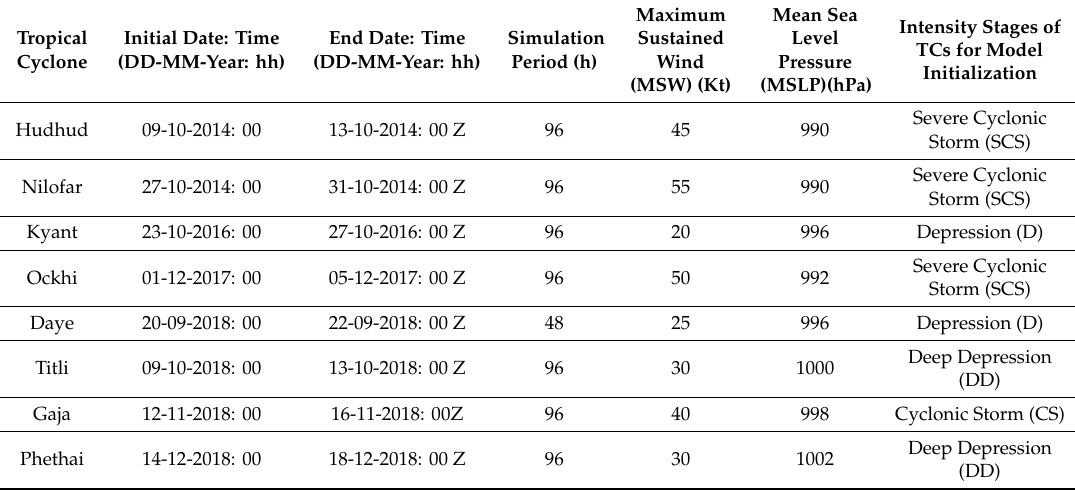
Table 3. Model initiation dates and simulation times considered for the study. Tropical